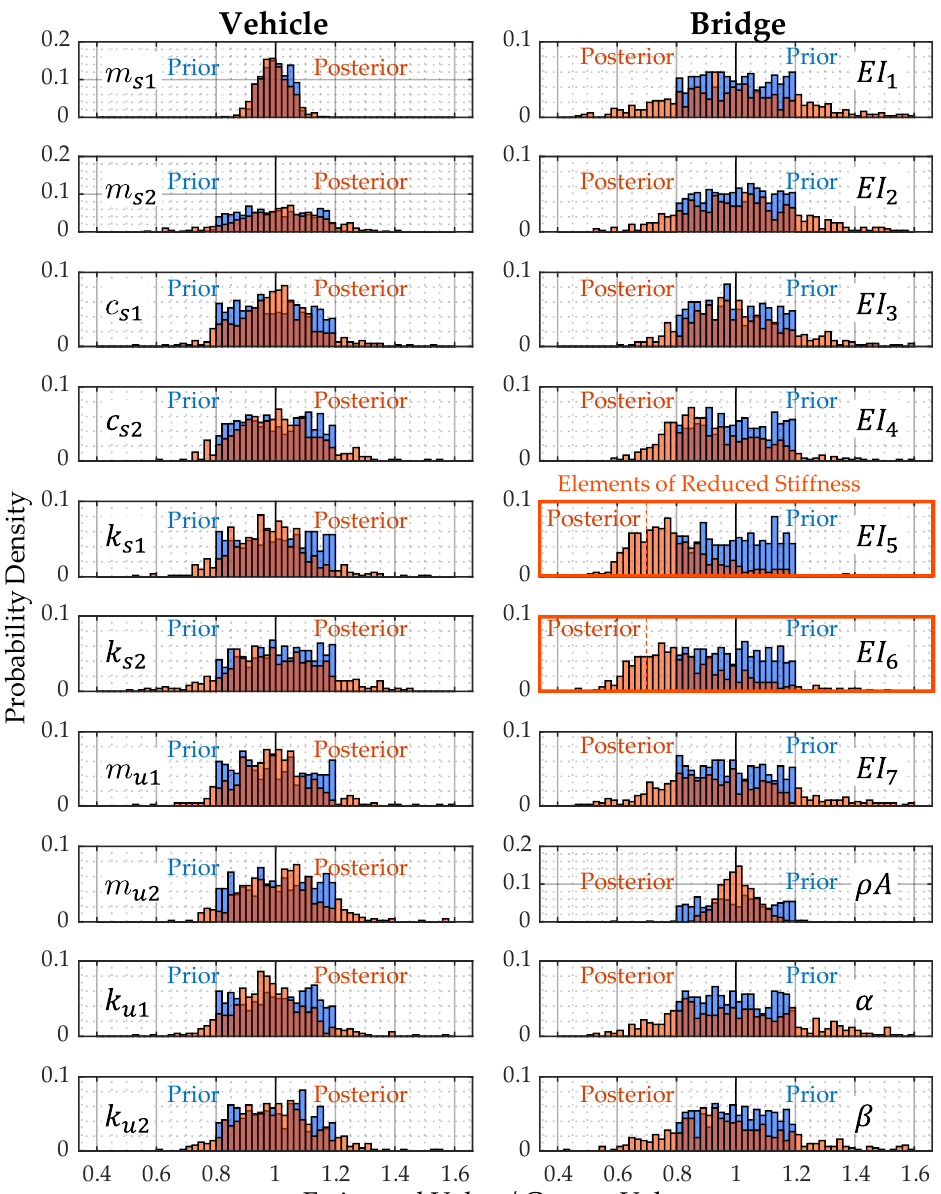
Figure A10. The application results of the PRE method in the case of Scenario 8 (stiffness decrease section: 4 L /7~6 L /7, decrease rate: 30%).